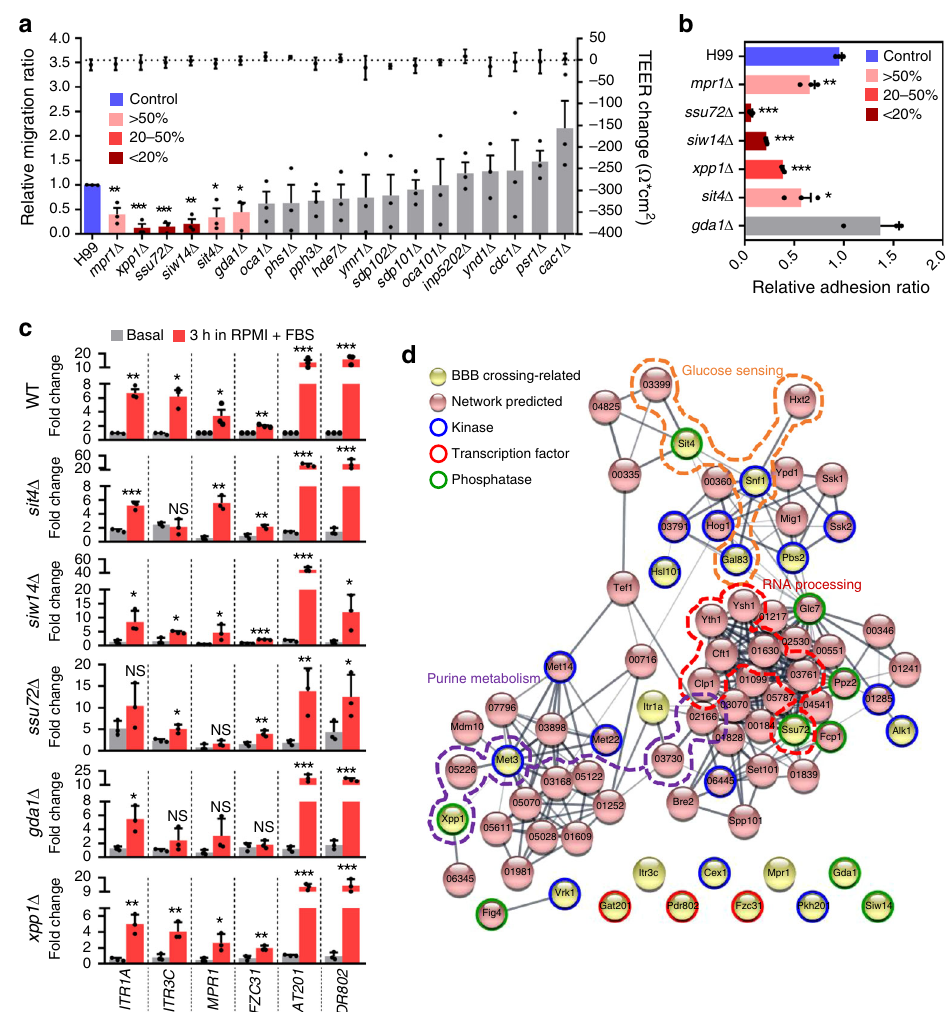
Fig. 7 In vitro BBB transmigration and adhesion assays for C. neoformans phosphatases. a In vitro BBB migration and b human brain microvascular endothelial cell line (hCMEC/D3) adhesion assay of pathogenicity-related phosphatases. Right: y -axis indicates trans-endothelial electrical resistance (TEER). Data plots represent individual data from three independent experiments ( n = 3). Data presented as mean values ± SEM. Signi fi cant differences were calculated by two-tailed (unpaired) Student ’ s t -test comparing wild-type (WT) and each phosphatase deletion mutant. c Host-mimic condition (HMC)-mediated induction of brain infection-related genes in wild-type (WT) and phosphatase deletion mutant strains. Gene expression was determined by quantitative RT-PCR with cDNA synthesized from total RNA prepared from cells shifted from basal condition (YPD at 30 °C, grey shaded) to HMC (RPMI with 10% foetal bovine serum at 37 °C under 5% CO 2 ) and further incubated for 3 h (red shaded). Fold-change of gene expression was calculated relative to basal expression levels of each gene in WT. Data from three independent experiments (black dots) are presented as mean values ± SEM. Statistical signi fi cance between basal and HMC was determined by two-tailed (unpaired) Student ’ s t -test (* P < 0.05; ** P < 0.001; *** P < 0.0001). d Functional protein association network analysis of BBB crossing-related TFs, kinases, and phosphatases of C. neoformans predicted by STRING (http:// string-db.org) with protein sequences obtained from FungiDB (https://fungidb.org/fungidb/). Images were drawn with Cytoscape v3.7.2. Dotted lines: groups of genes involved in purine metabolism (purple), RNA processing (red), and glucose sensing